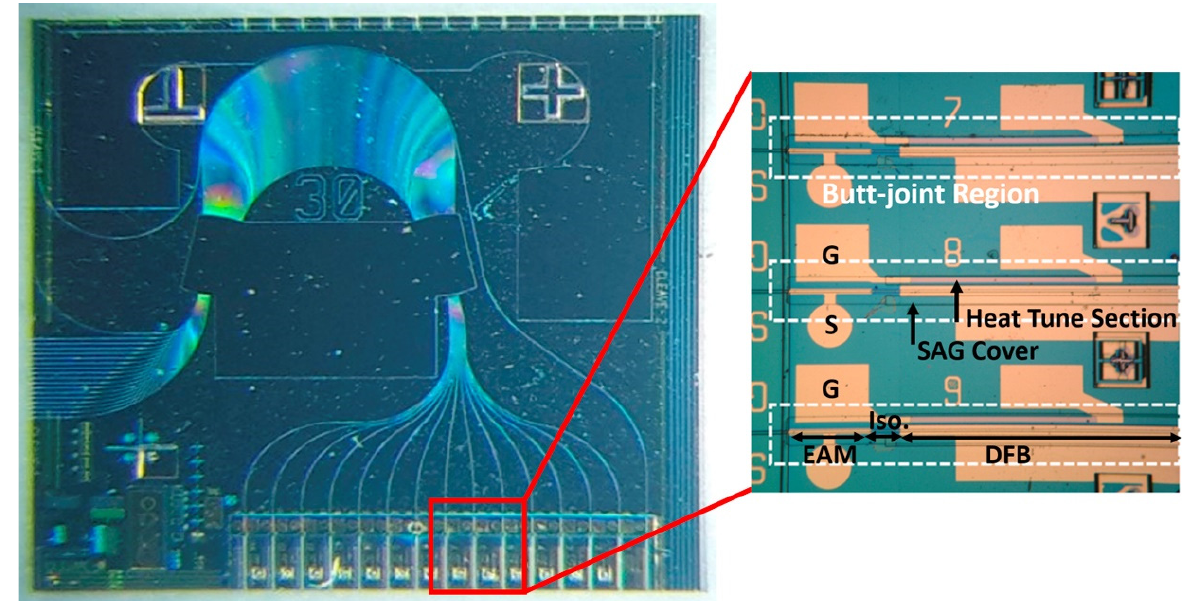
Figure 24. Optical graph of the fabricated device. The size of the integrated chip was 5800 × 5800 μ m 2 . The lengths of the DFB laser and EAM were 500 and 150 μ m, respectively. A 50 μ m isolation region was located between the EAM and DFB laser. Reprinted with permission from ref. [89] © Elsevier. Copyright 2017 Optics & Laser Technology.